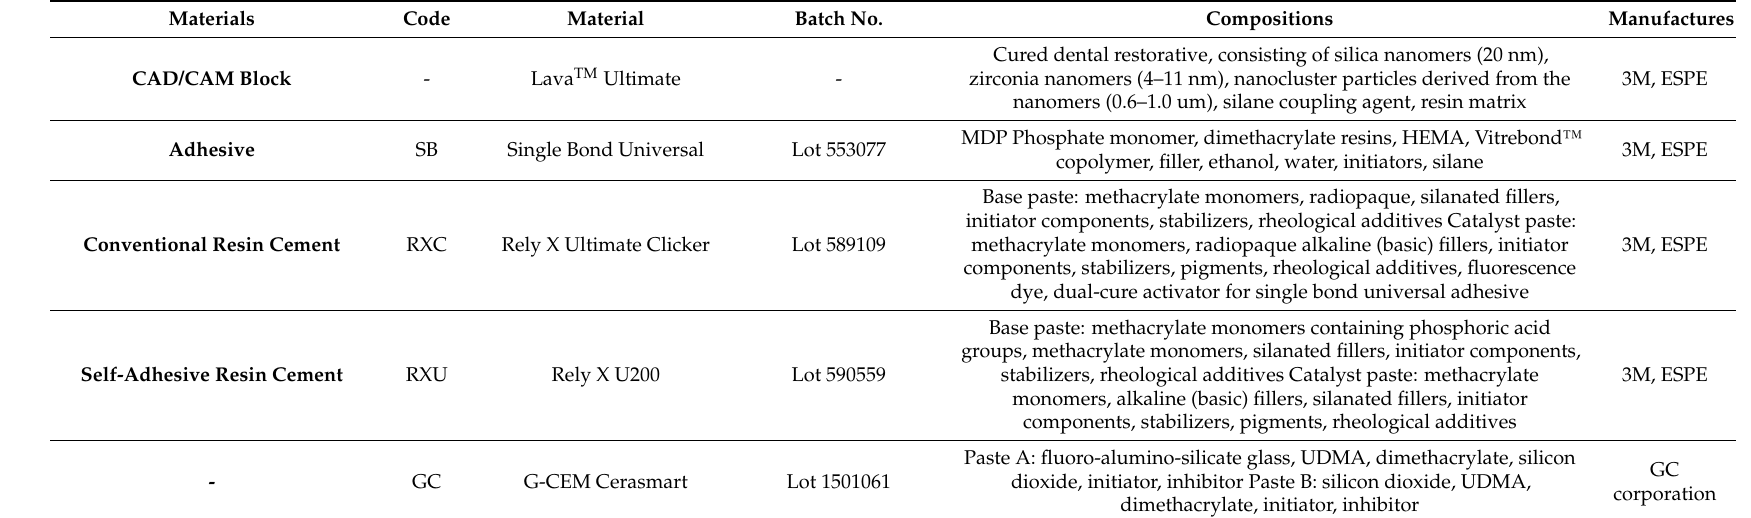
Table 1. Composition and information of dentin adhesive systems and rewetting agents used in this